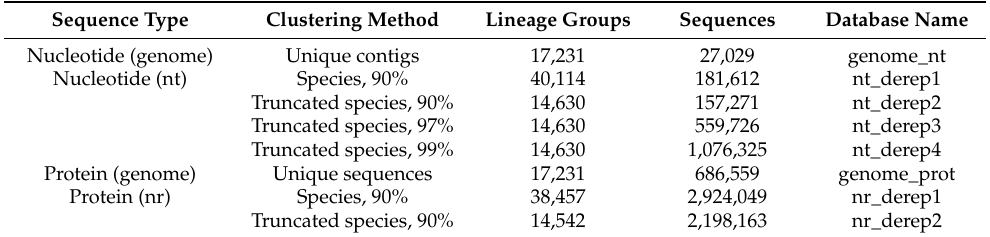
Table 2. Summary statistics for the candidate nucleotide and protein sequence databases constructed for testing.